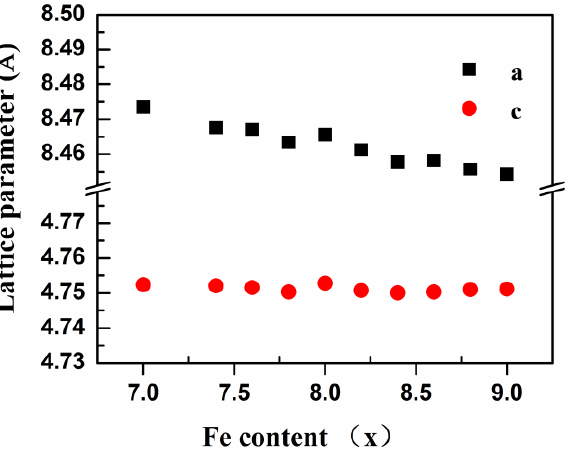
Figure 1. Variation of lattice constants a and c with Fe content of ErFe x Mn 12 − x (7.0 ≤ x ≤ 9.0) series alloys after heat treatment.